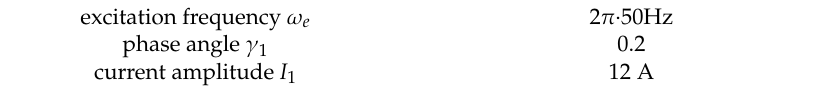
Table 3. Investigated operating point.